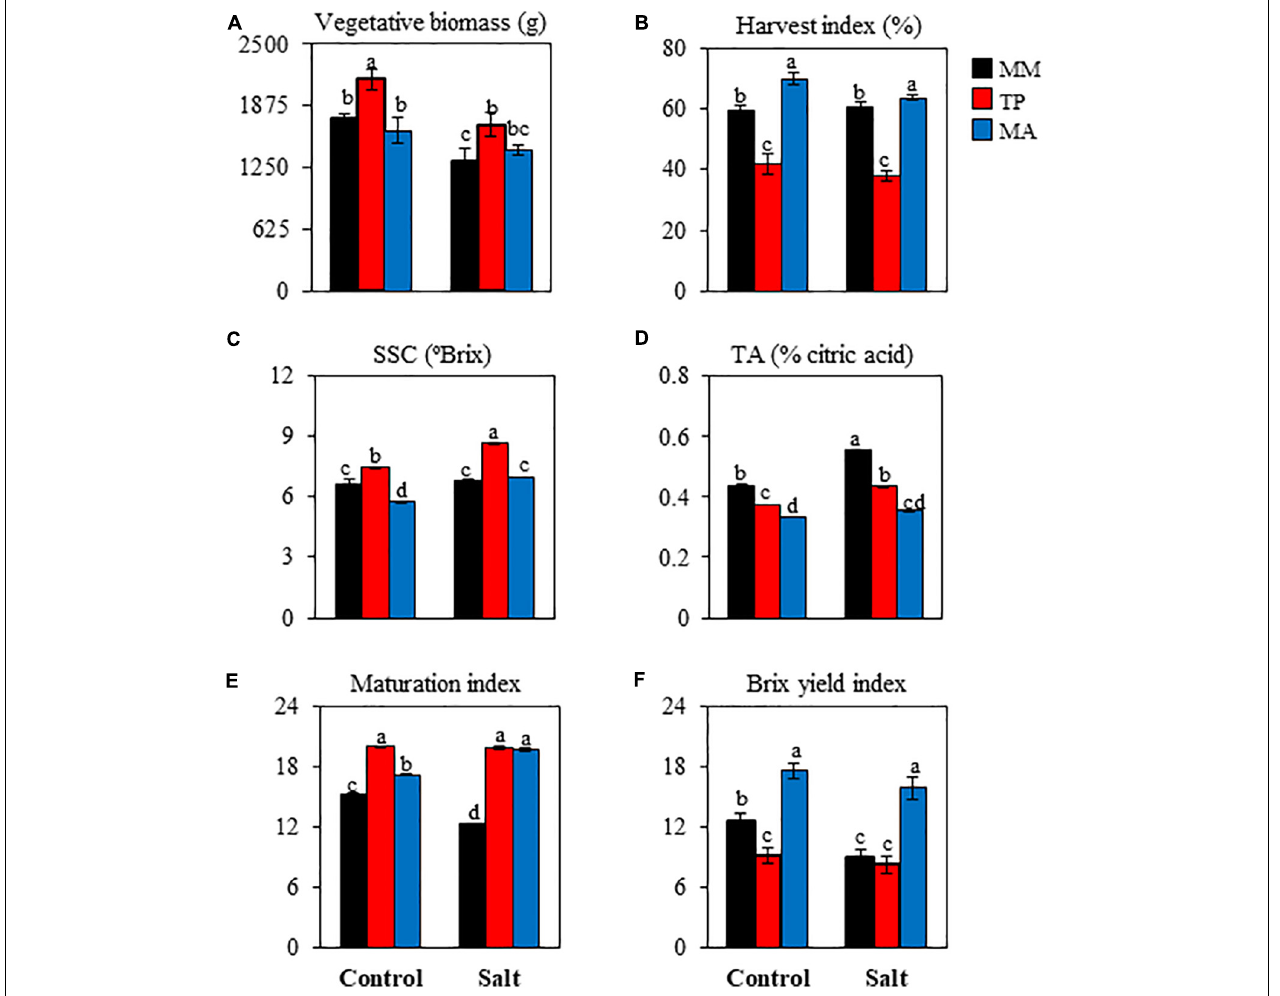
FIGURE 2 | Agronomic and organoleptic quality parameters in red ripe fruits of tomato “Moneymaker” (MM) and two traditional varieties, “Tomate Pimiento” (TP) and “Muchamiel Aperado” (MA), from plants grown in control and salt (50 mM NaCl). (A) Vegetative biomass, (B) harvest index, (C) soluble solid content (SSC), (D) titratable acidity (TA), (E) Maturation Index (SSC/TA), (F) Brix yield index (SSC × fruit yield). For agronomic data, seven plants were individually harvested; for quality traits, three biological replicates of 10 fruits each were used. Values are expressed as means ± SE. Different letters indicate statistically significant differences according to Tukey’s test ( p <